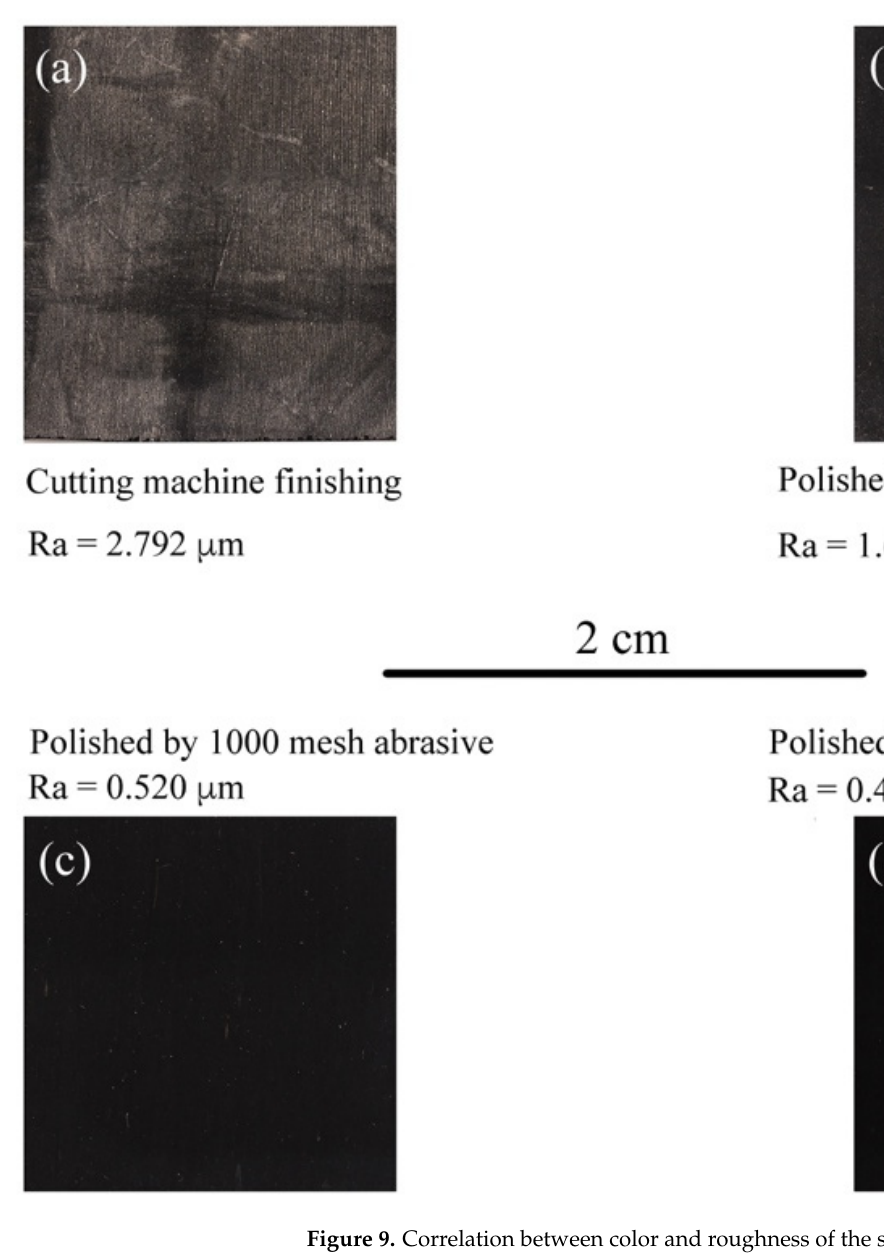
Figure 9. Correlation between color and roughness of the slate: a lower roughness (Ra) corresponds to a darker color with a progressive decreasing of L* parameter. ( a ) Cutting machine finishing; ( b ) polishing by FEPA P400-mesh abrasive (35 mm, 0.0014”); ( c ) polishing by FEPA P1000-mesh abrasive (18.3 mm, 0.007”); ( d ) polishing by FEPA P4000-mesh abrasive (5 mm, 0.0002”).